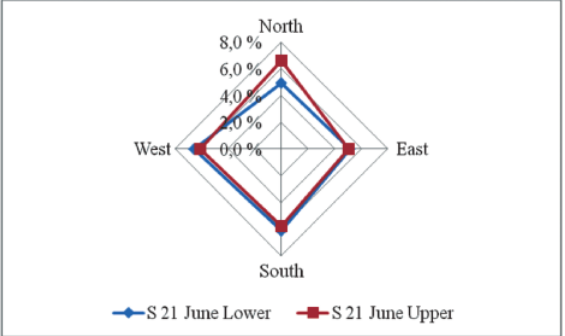
Fig. 14: Stone-pulp ratio in the function of orientation and height in the case of Stella